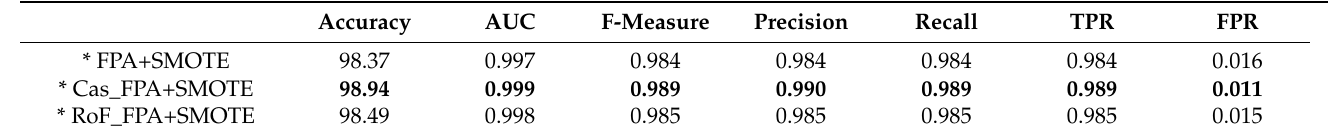
Table 13. Detection performance of FPA, Cas_FPA, and RoF_FPA on the SMOTE-balanced Drebin